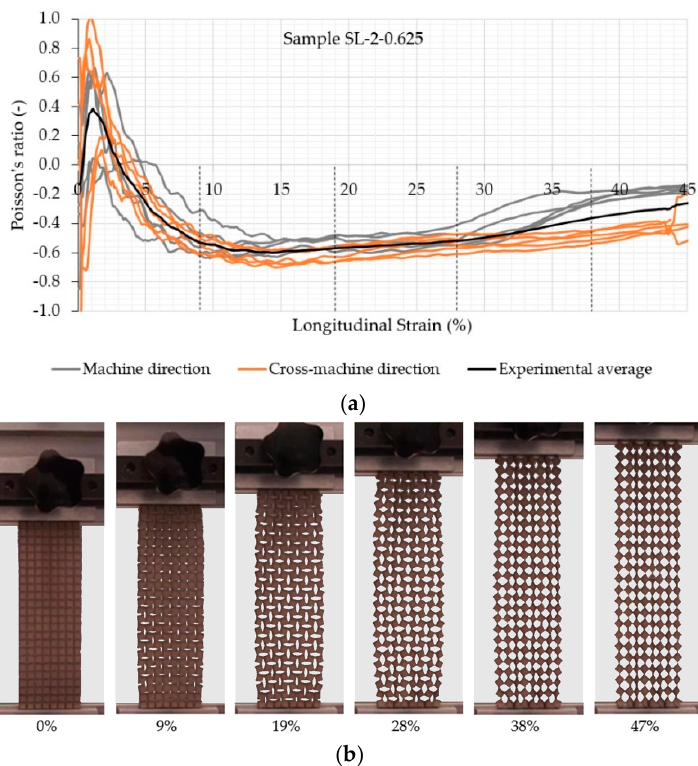
Figure 8. ( a ) Evolution of the Poisson’s ratio with the longitudinal strain of the auxetic sample SL-2-0.625 and ( b ) fabric deformation at different longitudinal strains during tensile testing in the machine direction.